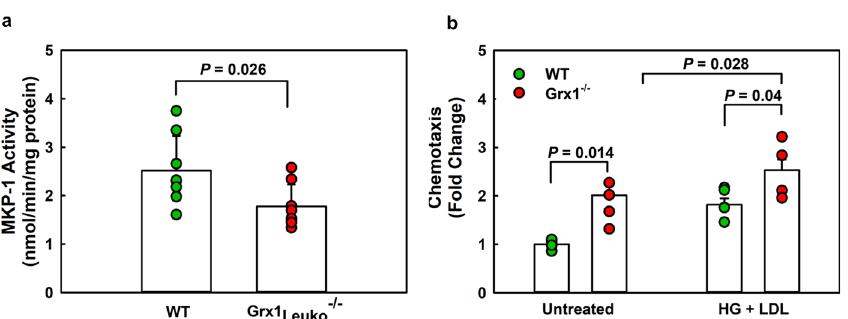
Fig. 8 Hematopoietic Grx1 de fi ciency promotes atherosclerosis in reproductively healthy female LDLR -/- mice by enhancing recruitment of monocyte- derived macrophages into atherosclerotic lesions. a Representative images of Oil Red O-stained aortas from female LDLR -/- Grx1 Leuko -/- mice (Grx1 Leuko -/- ) and age-matched female LDLR -/- mice (WT) fed a HCD. b Quanti fi cation of aortic lesion area. n = 14 per group. Week 6: n = 10; Week 20: n = 14. c Representative images of Oil Red O-stained sections from the aorta roots of HCD-fed female LDLR -/- Grx1 Leuko -/- (Grx1 Leuko -/- ) and age-matched female LDLR -/- mice (WT). Scale bar = 500 μ m. d Quantitation of lesion area in the aortic root. Week 6: n = 10; Week 20: n = 14 per group. e Distribution of lesion size across a 500 μ m segment of the aortic root beginning at the aortic valve. n = 14 mice per group. f Recruitment monocyte-derived macrophages into implanted Matrigel plugs loaded with. MCP-1. n = 14 mice per group. g Representative images of aortic root sections stained with a macrophage-speci fi c antiserum against CD68. Scale bar = 500 μ m. h Quantitation of macrophage content in atherosclerotic lesions in the aortic root. Week 6: n = 10; Week 20: n = 14 mice per group. All data are expressed as mean ± S.E. One-way ANOVA followed by Fisher ’ s Least Signi fi cance Difference test was used to compare the mean values between experimental groups. Source data are provided as a Source Data fi le.